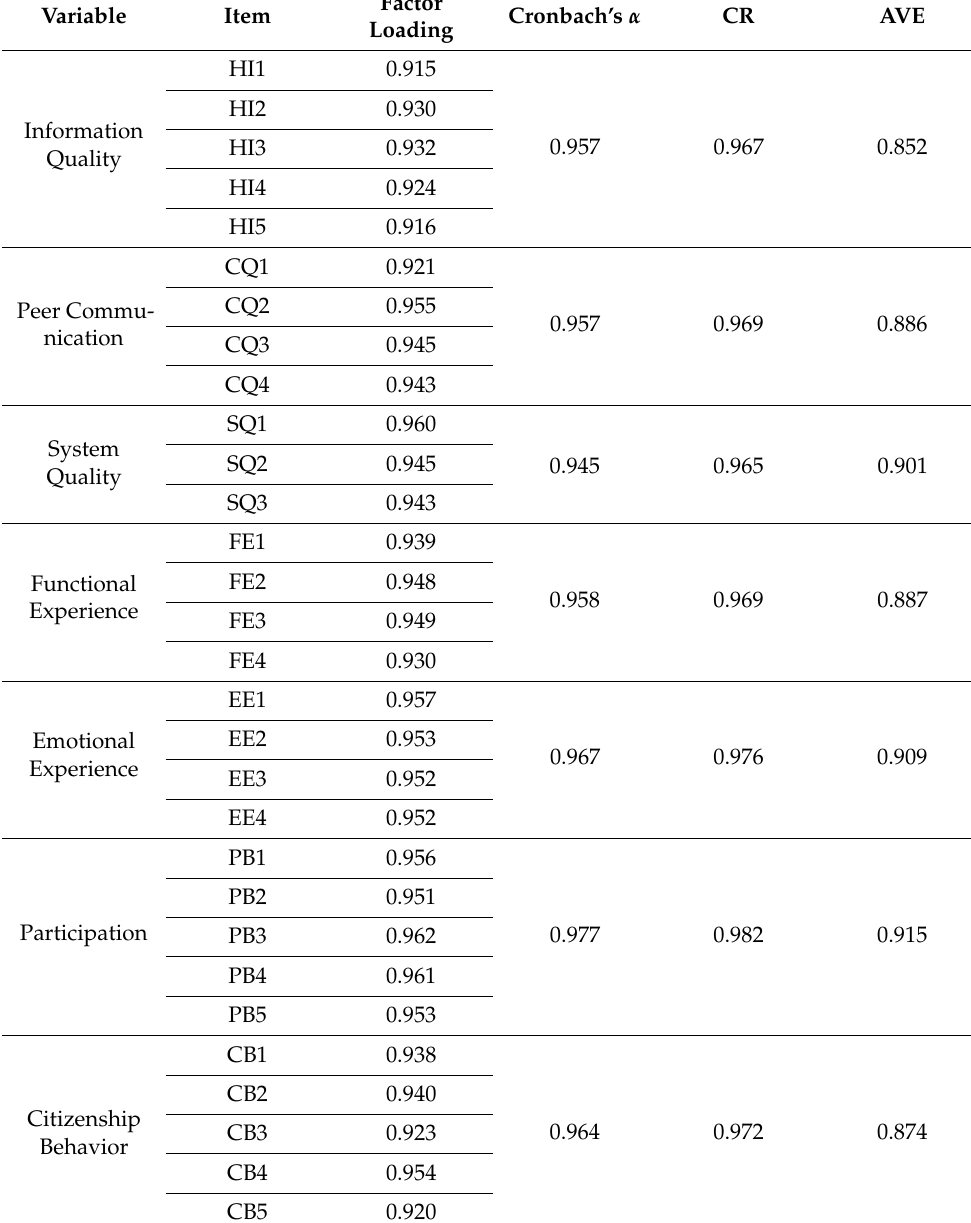
Table 3. Reliability and